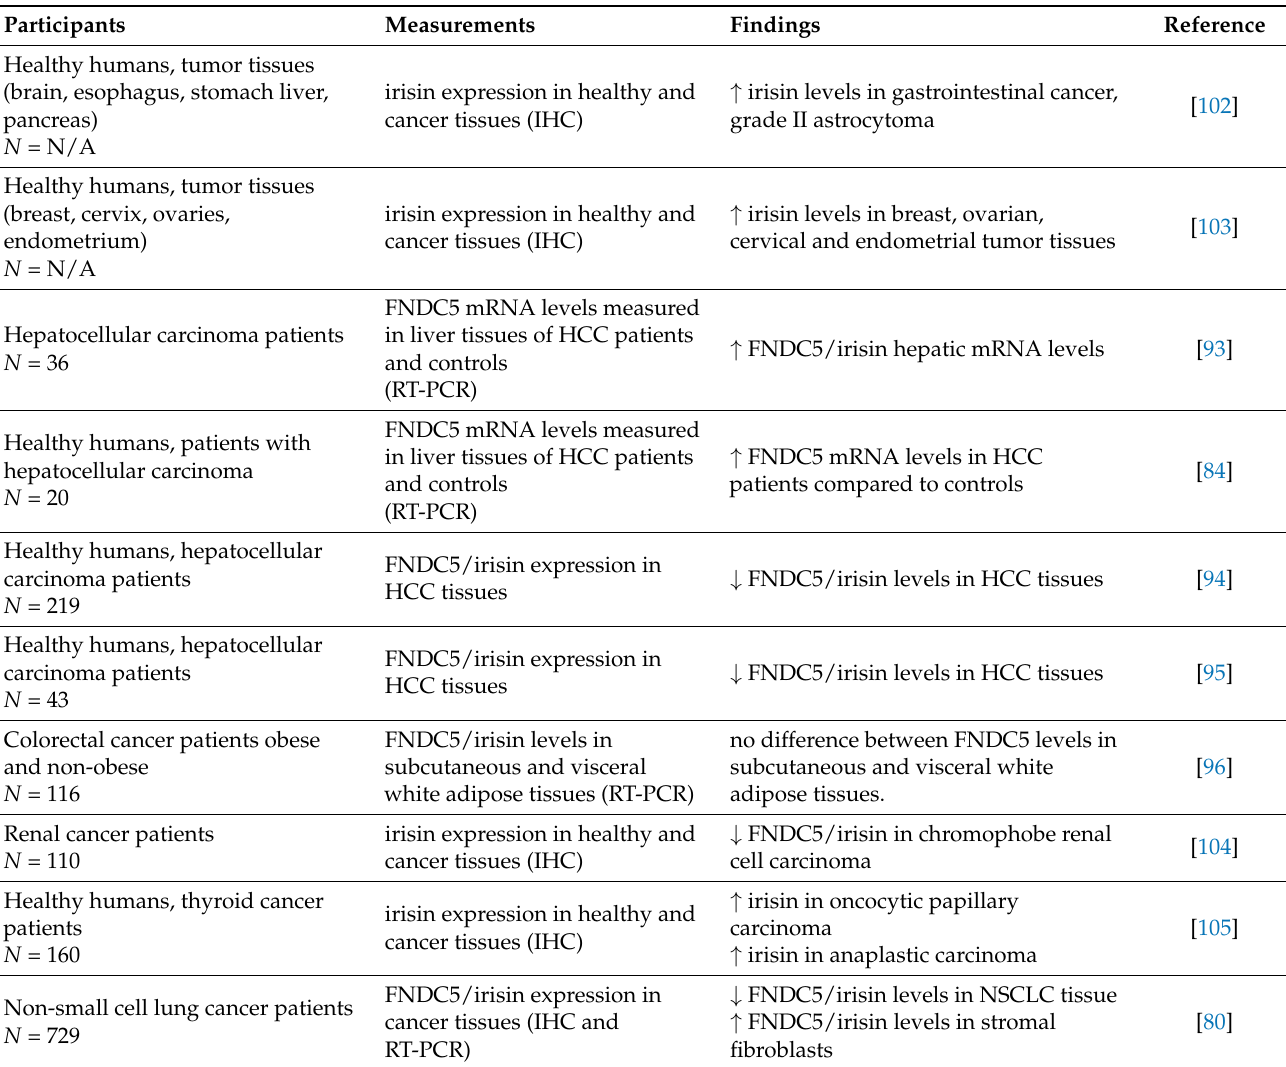
Table 4. Role of irisin in cancer: in vivo evidence from human studies measuring irisin in cancer